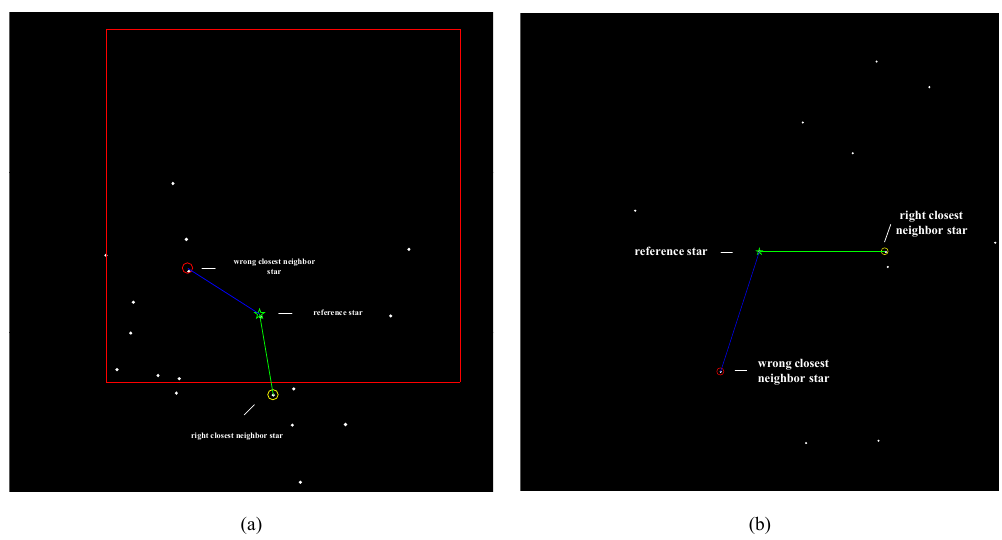
Figure 4. Illustration of incorrect closest-neighbor stars. ( a ) Incorrect case due to the absence of the nearest star in the FOV. ( b ) Incorrect case due to star positioning errors of multiple star points. 3)